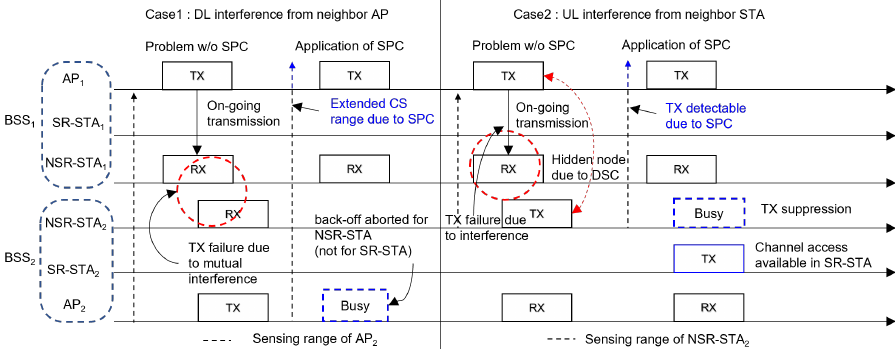
Figure 3. Two operational examples of supplemental power control